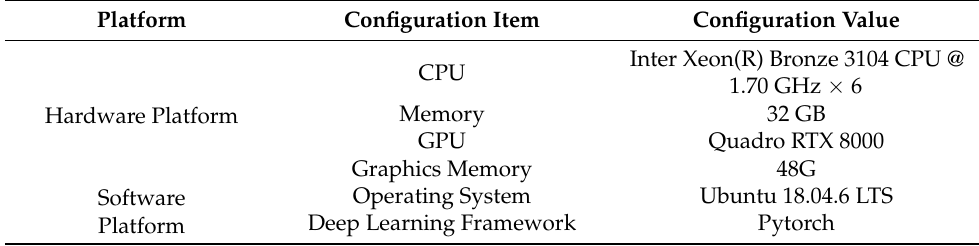
Table 2. Training environment configuration.